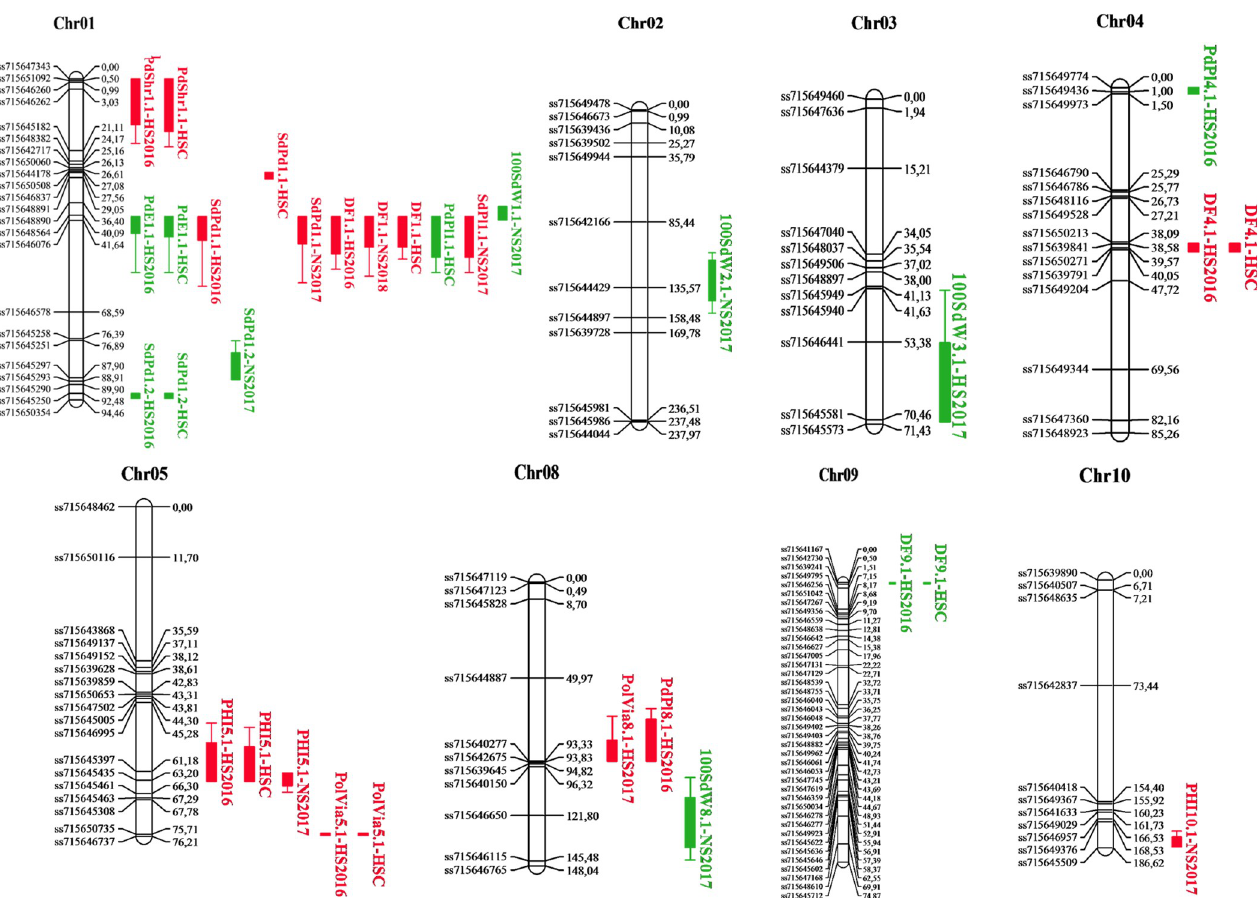
Fig 7. QTLs identified in the IJR x AFR298 population evaluated under heat stress (HS) and non-stress (NS) conditions. Evaluation of 107 lines with 162 polymorphic markers identified QTLs for nine traits. The eight chromosomes that harbor these QTLs are shown. The source of the positive allele is indicated in red for IJR and green for AFR298. For trait abbreviations see Table